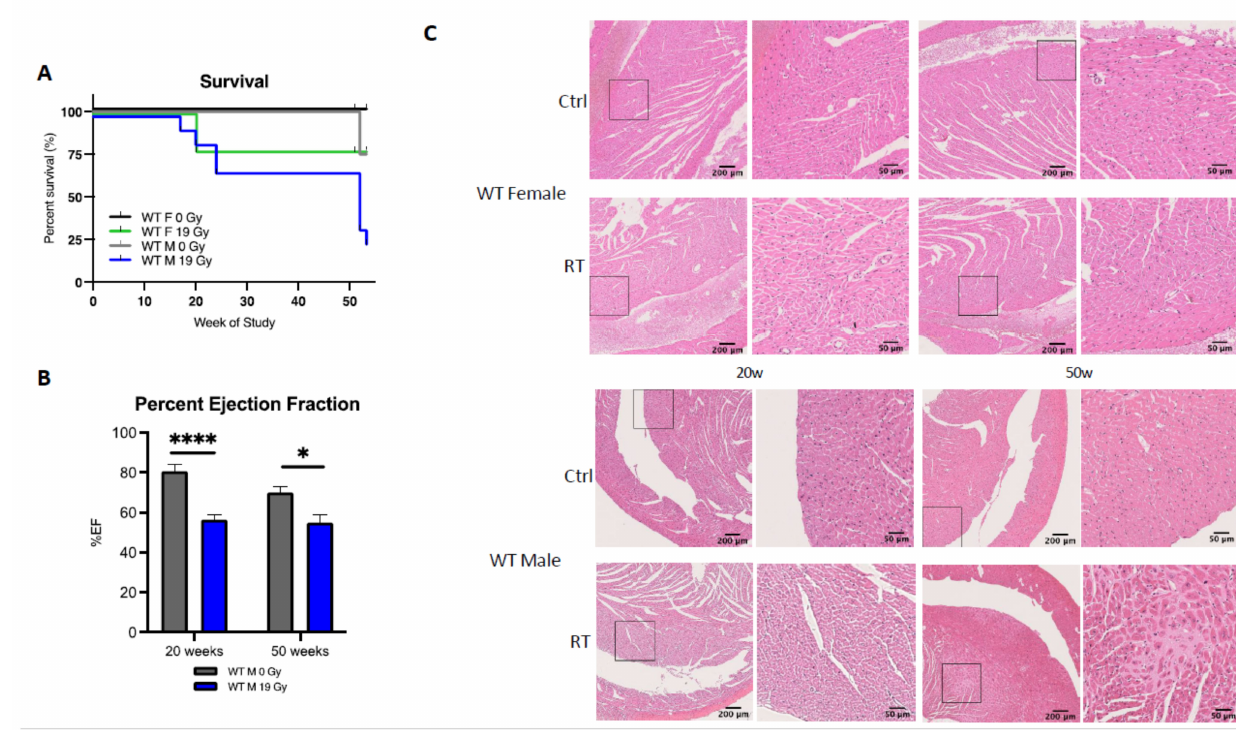
Figure 2. Wild-type females are protected from cardiotoxicity induced by RT (19 Gy). ( A ) Survival curves show that 77% of WT males died ( n = 9), while 25% of WT females ( n = 12) were alive 50 weeks post-19 Gy thoracic irradiation. Log-rank (Mantel–Cox) test p = 0.0021. ( B ) Significant change in %EF after exposure was shown in WT males ( p = 0.0003). Multiple comparisons measure significant changes after 19 Gy at 20 weeks ( p < 0.0001) and 50 weeks ( p = 0.0127). Graphs designate mean ± s.e.m; p- value derived from multiple comparisons mixed-effect model (REML), Bonferroni test: * p < 0.05 and **** p < 0.0001. ( C ) Representative images of H&E-stained cardiac tissue showed no alteration of cardiac structure 20 weeks post-RT in females and males with a sex-specific evolution in time. Alterations of the cardiac structure were observed in males 50 weeks post-RT with larges patches of replacement amyloidosis/fibrosis deposition and scarring tissue associated with immune infiltration, whereas in females, cardiac structure remained